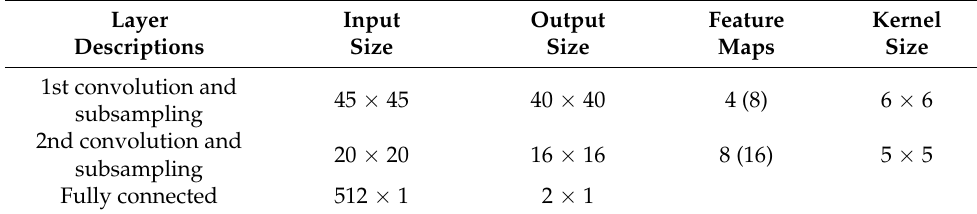
Table 1. The details of the CNN